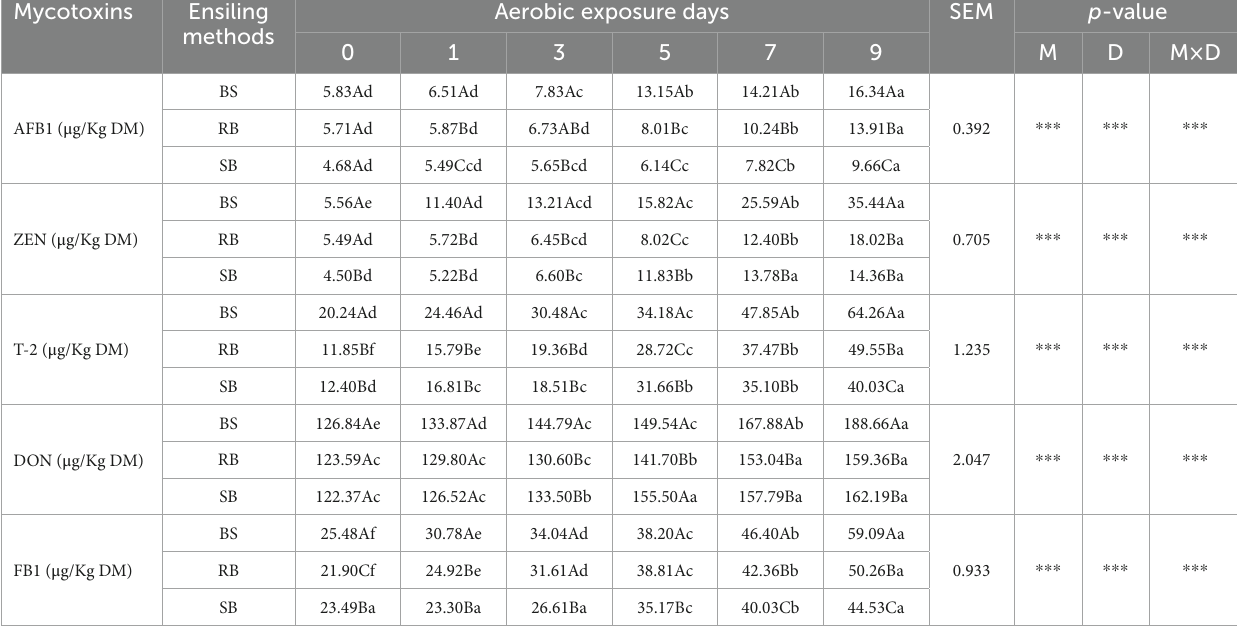
TABLE 3 Effect of different ensiling methods on mycotoxins concentration of WPCS during aerobic exposure.